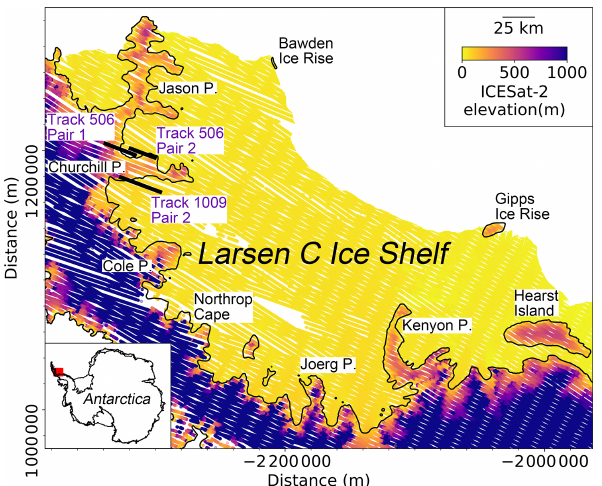
Figure 2. Locations and surface elevations of ICESat-2 ground tracks from repeat cycles 3–6 on Larsen C Ice Shelf in Antarctic polar stereographic (epsg:3031) projection. The black line is the grounding line (GL) from Depoorter et al. (2013). The red box on the inset map shows the location of Larsen C Ice Shelf.